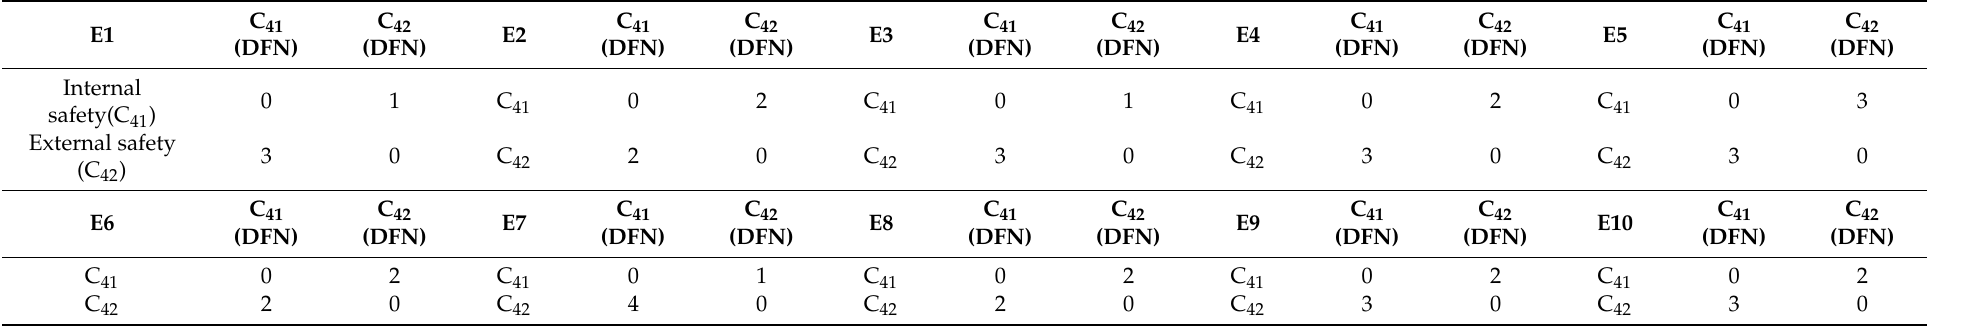
Table A5. Degree of direct fuzzy influence between Safety (C 4 )